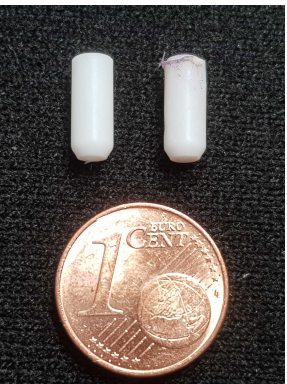
Figure D1. A bullet before (left) and after (right) the shot. Defor- mations are visible at the top and at the side. The bullets have an opening at the top and an internal volume of approximately